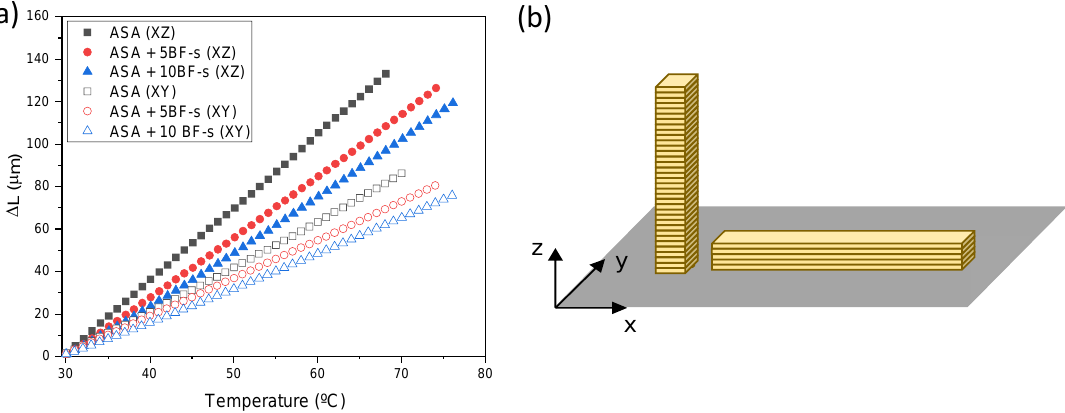
Figure 8. ( a ) TMA curves of ASA (black), ASA + 5BF-s (red) and ASA + 10BF-s (blue). Filled symbols represent the specimens tested vertically (labelled as XZ) and hollow symbols represent the specimens printed horizontally (labelled as XY); ( b ) cartoon depicting the disposition of the specimens in the printing platform for easier interpretation of ( a ).